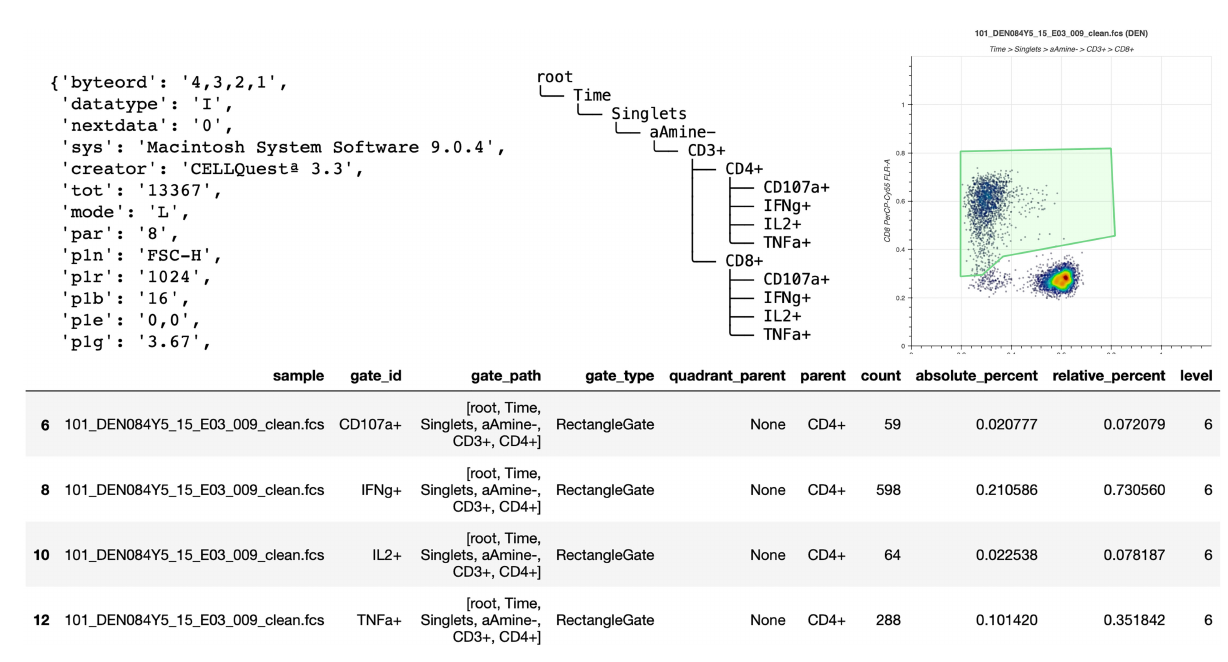
FIGURE 1 | Basic elements provided by FlowKit for generating reports and downstream analysis. Clockwise from top left – metadata as key:value pairs, gating hierarchy as ASCII text, scatter plot of a gate, DataFrame of results from applying gating strategy speci fi ed in the Session